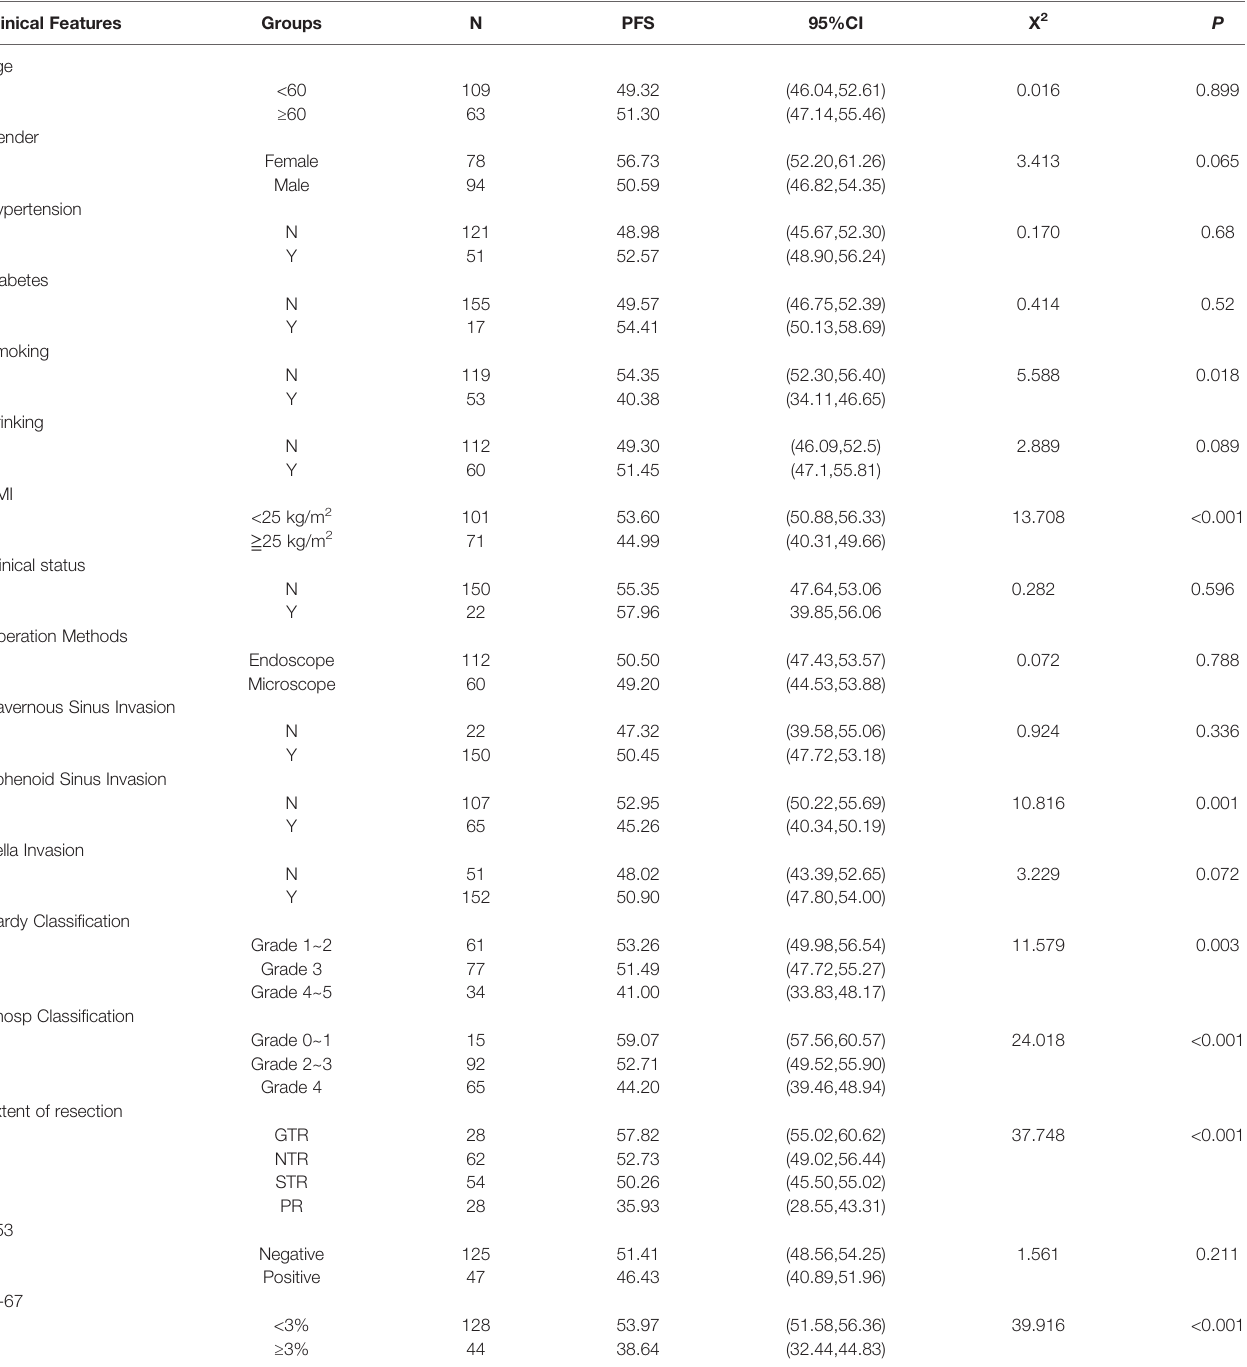
TABLE 2 | Univariate analysis results and mean PFS for each